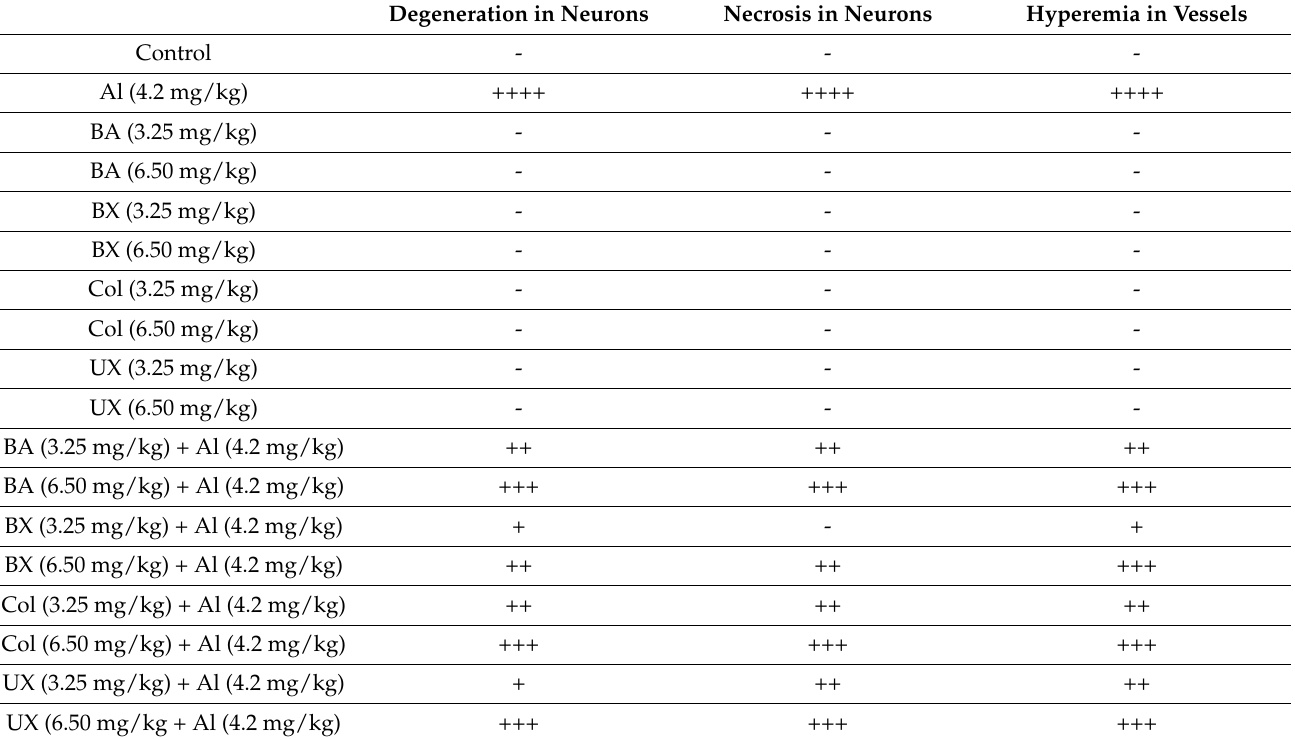
Table 5. Scoring of histopathological findings observed in the cerebral cortex after treatments with boron compounds and Al. (- nonsignificant; + significant at %0.01; ++ significant at %0.1;